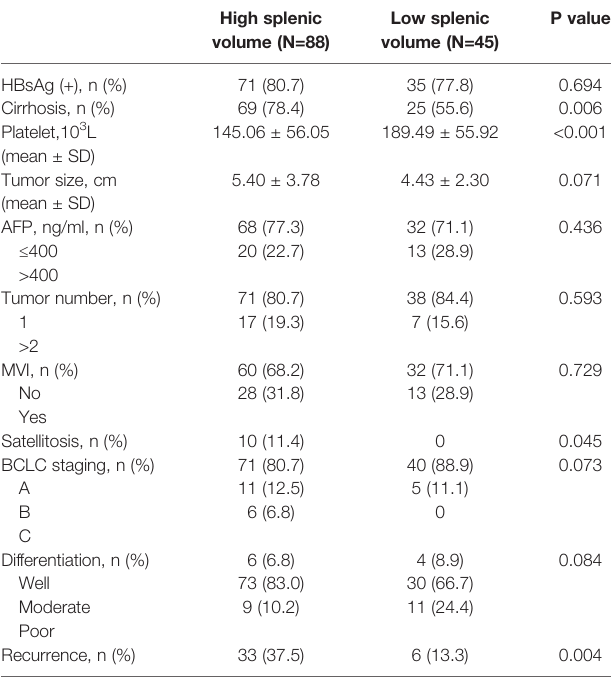
TABLE 4 | Comparison of clinicopathological factors between high splenic volume and low splenic volume group. High splenic volume (N=88)